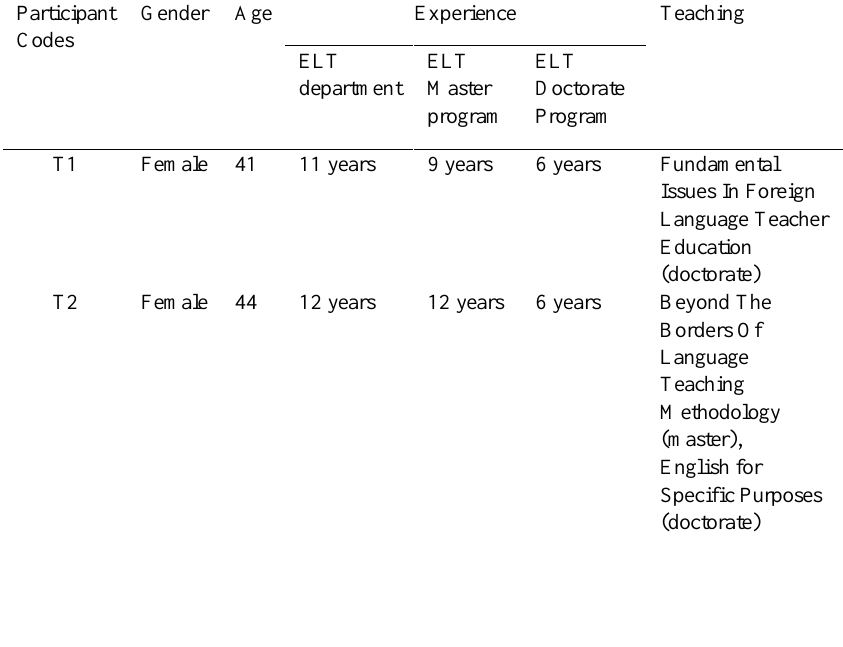
Personal information of the academics